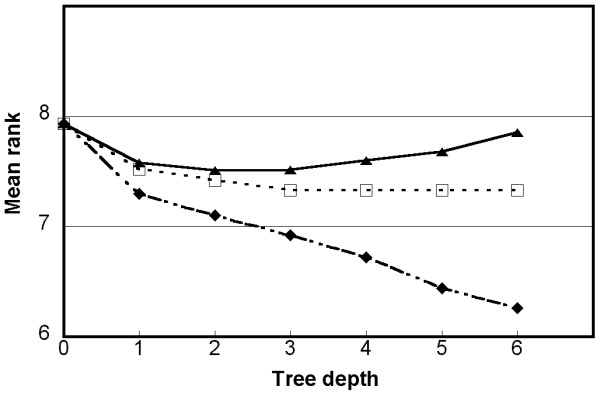
Evolution of the Mean Rank criterion averaged over Alanine residues at different tree depths. Values are indicated for the evaluations of the learning set (filled diamonds), of the test set before pruning (filled triangles) and after pruning the decision tree (open squares).